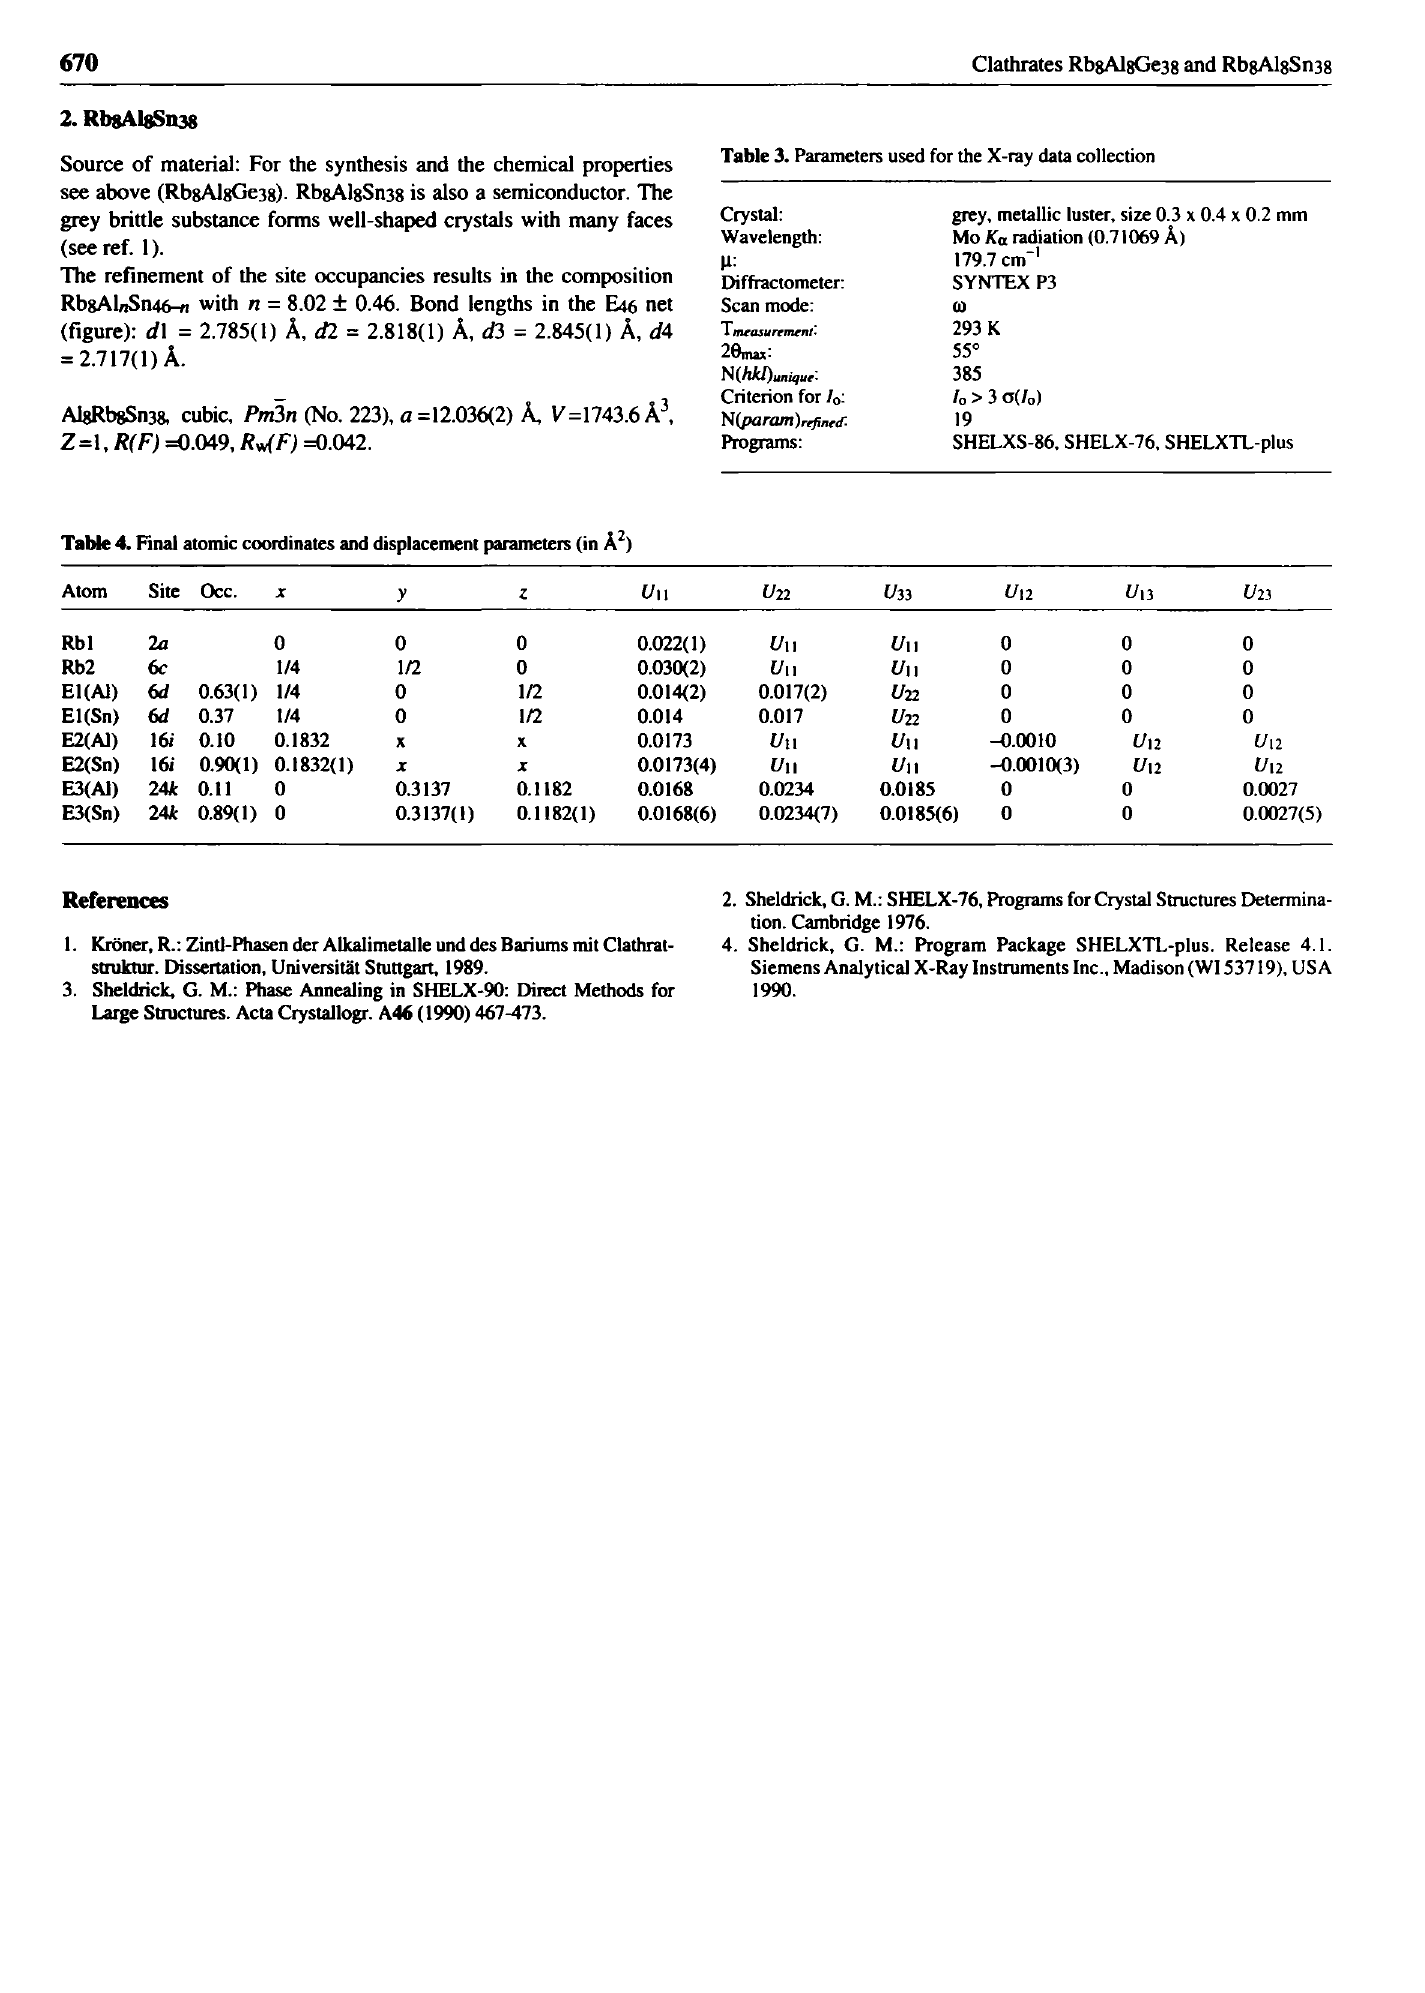
Table 3. Parameters used for the X-ray data collection Crystal: